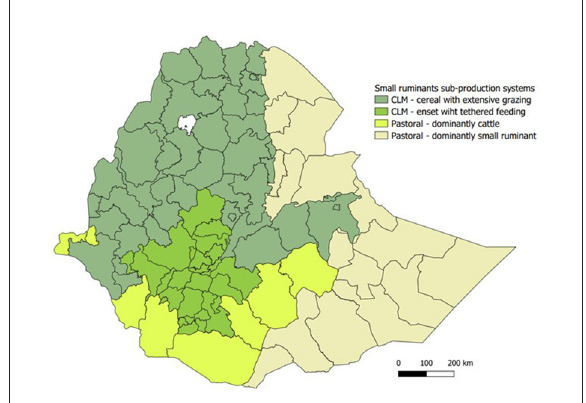
FIGURE1 Map of small ruminant production systems. The divisions in the map indicate zones.